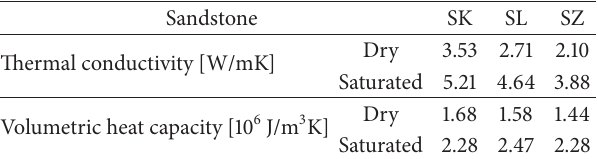
Table 9: Thermal parameters.